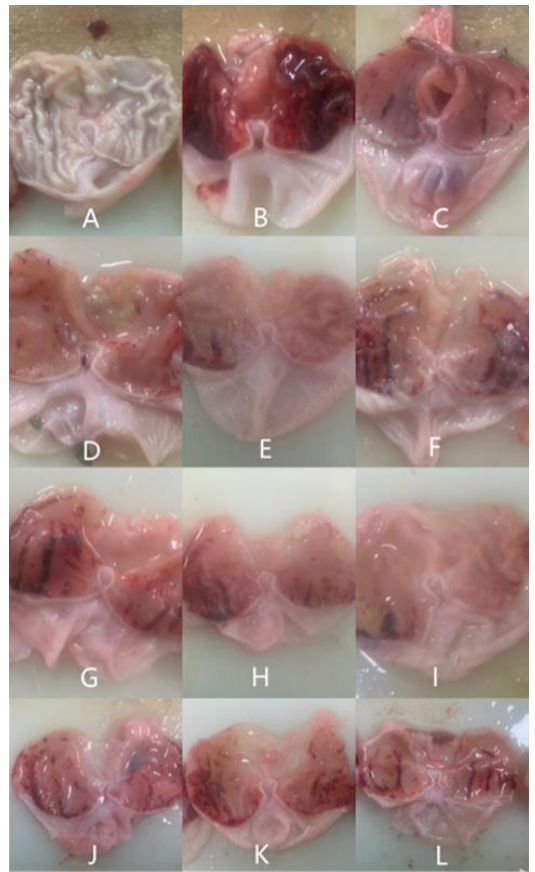
Figure 1. Macroscopic photo images of stomach tissue in rats. Blank group ( A ), Model group ( B ), Positive group ( C ), GLP100-H ( D ), GLP100-M ( E ), GLP100-L ( F ), GLP10-H ( G ), GLP10-M ( H ), GLP10-L ( I ), GLP1-H ( J ), GLP1-M ( K ), GLP1-L ( L ).